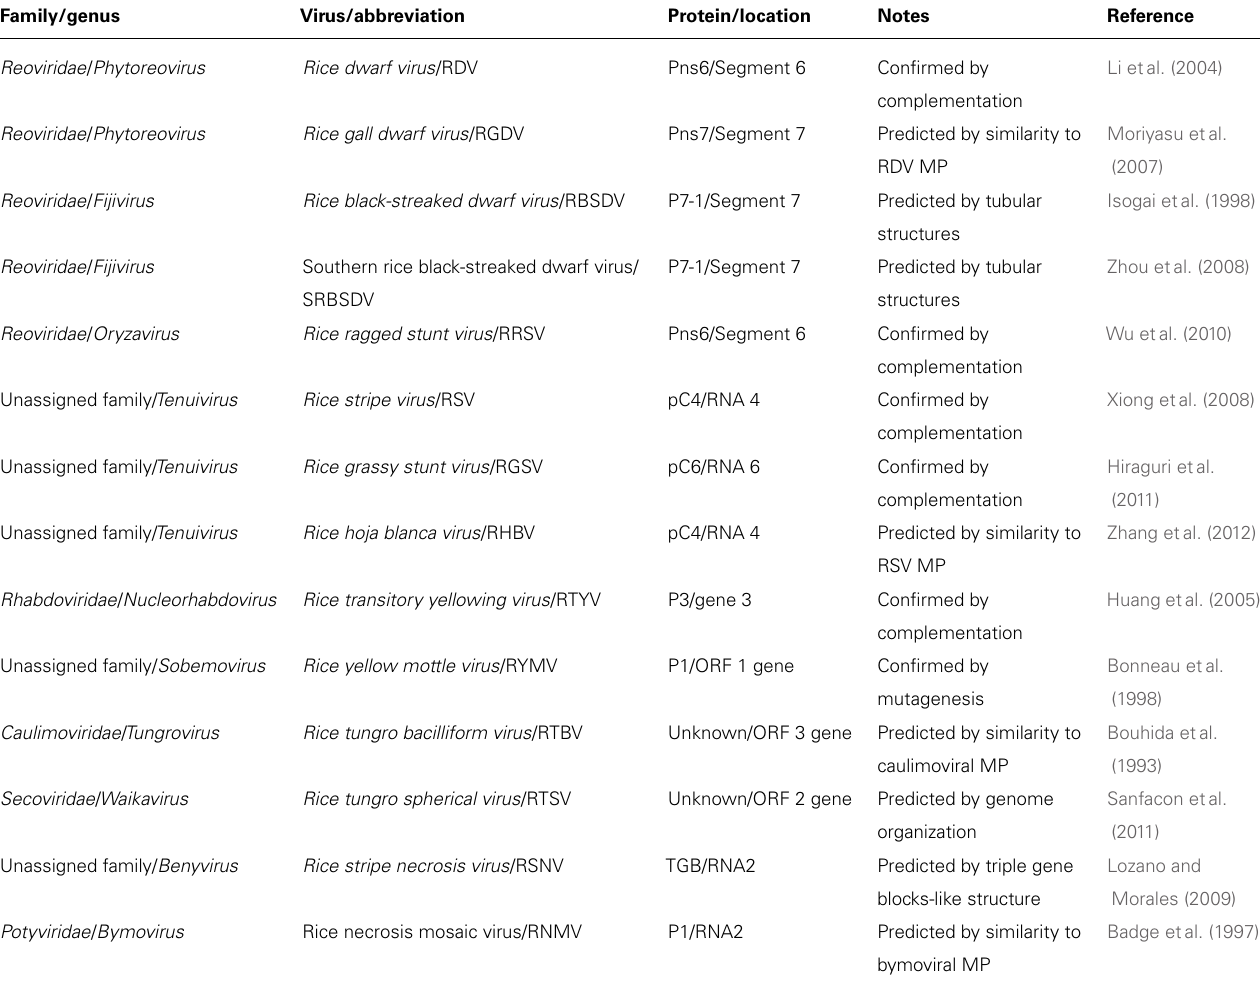
Table 1 | Overview of movement proteins of rice